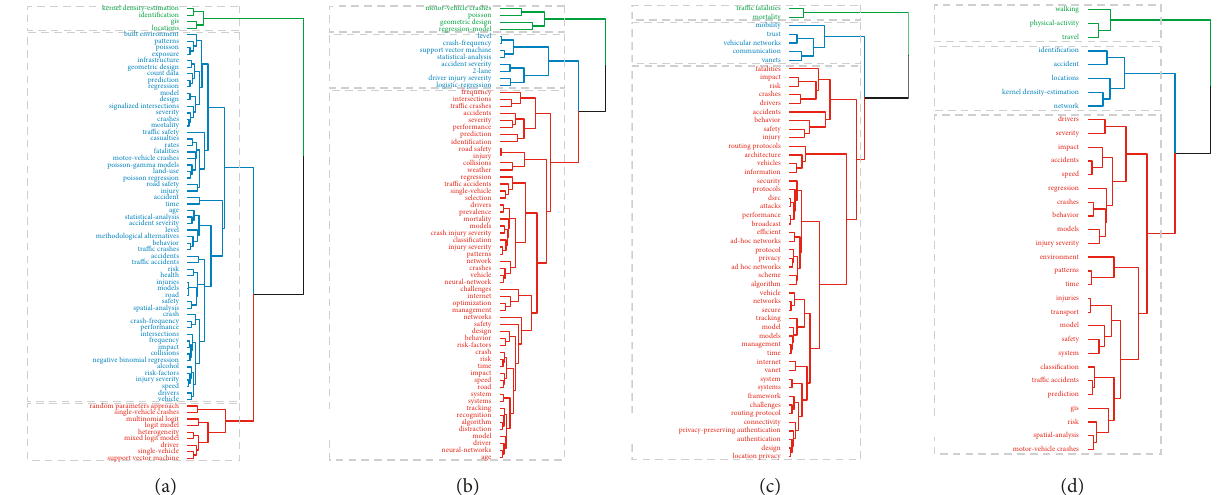
Figure 5: Dendrogram of main topics based on the analytical methods used for analyzing road traffic accidents in the (a) RTA+ HA+SM, (b) RTA +HA +ML, (c) RTA+HA +SC, and (d) RTA+HA +GIS